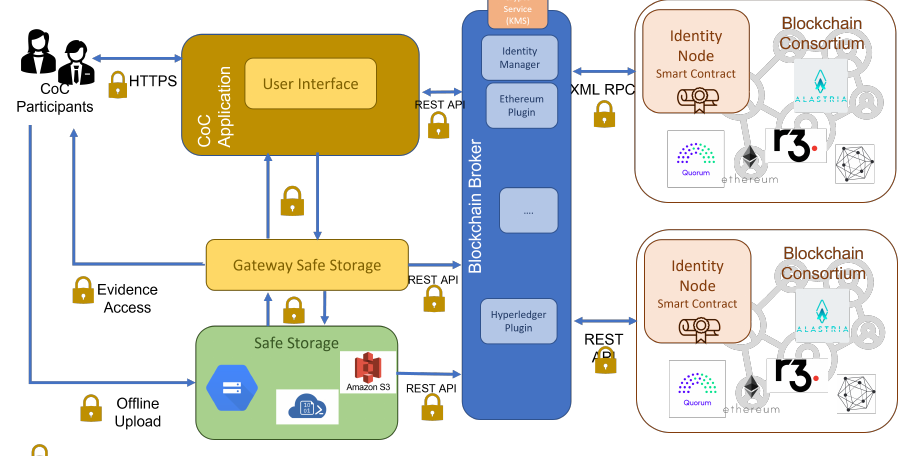
Figure 4. Centralized Architecture.